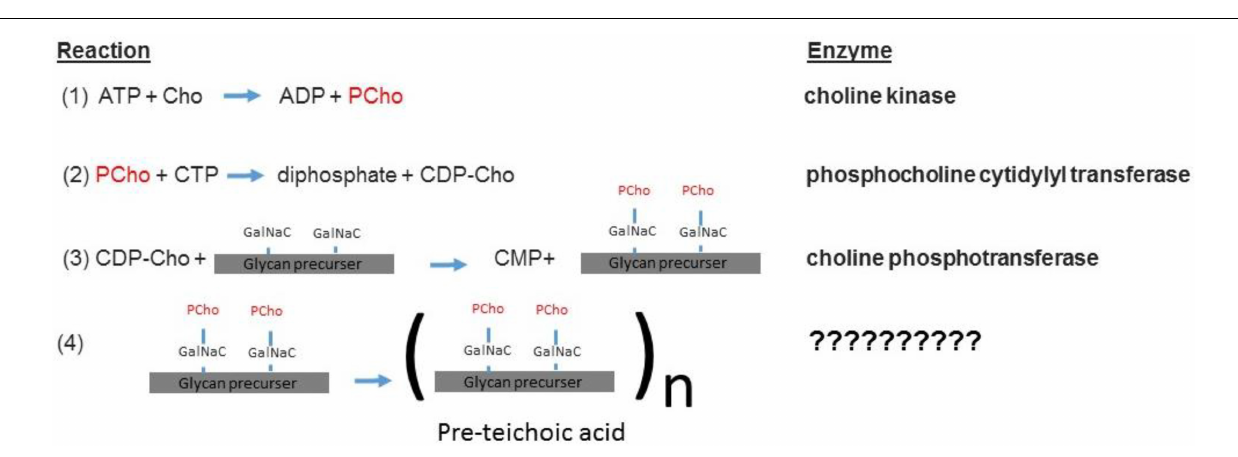
FIGURE 4 | The sChok pathway and how it fits into the overall process of teichoic acid assembly (Denapaite et al.,